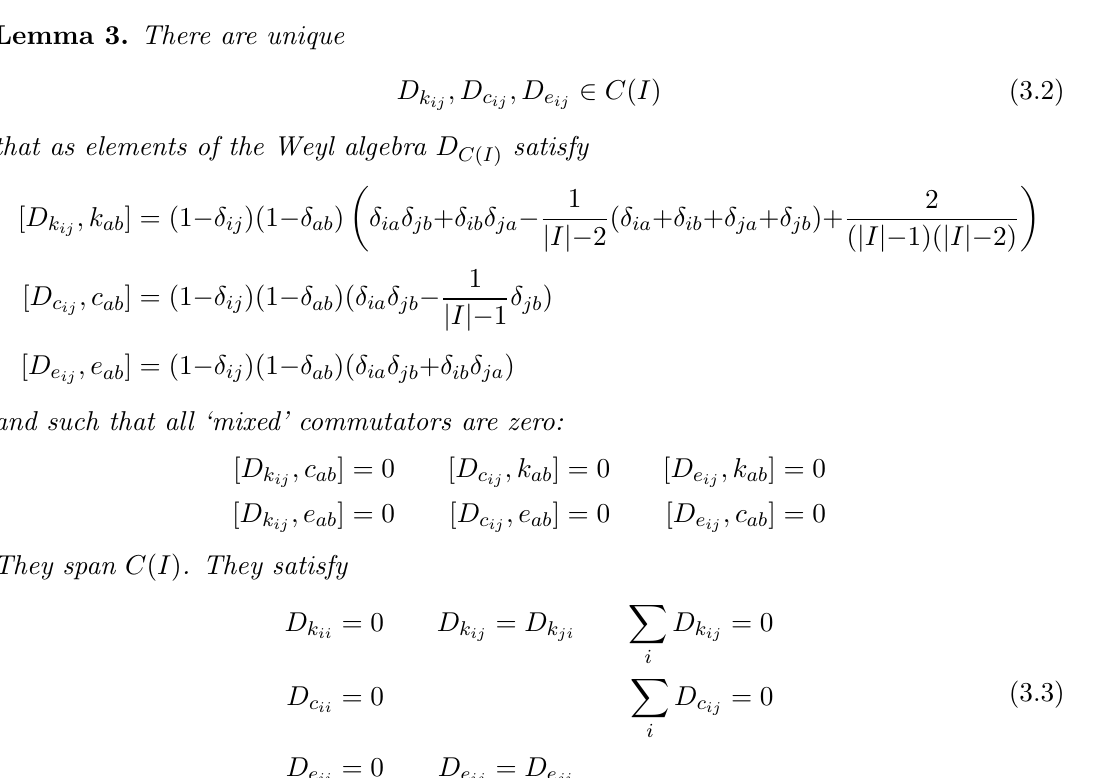
Figure 1 . Decomposition of C ( I ) associated to the decomposition I = J ⊔ K . The coordinates k ⊥ , c ⊥ , e ⊥ are uniquely determined by being constant in the direction Ξ and coinciding with k , c , e respectively along C ( I ) ⊥ . The derivatives D ⊥ span C ( I ) ⊥